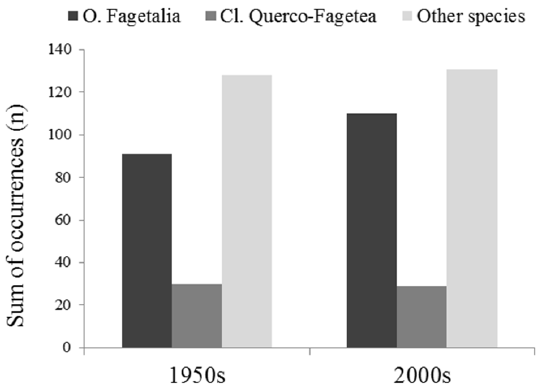
Figure 4. Changes in the occurrence of herbaceous plants typical of the phytosociological units between sampling periods. In the case of diagnostic species for mesophytic and eutrophic forests of the order Fagetalia , the sums of occurrences in study plots from the 1950s were increased by the 2000s as a result of the spread of species typical of beech forests (more details in the text).